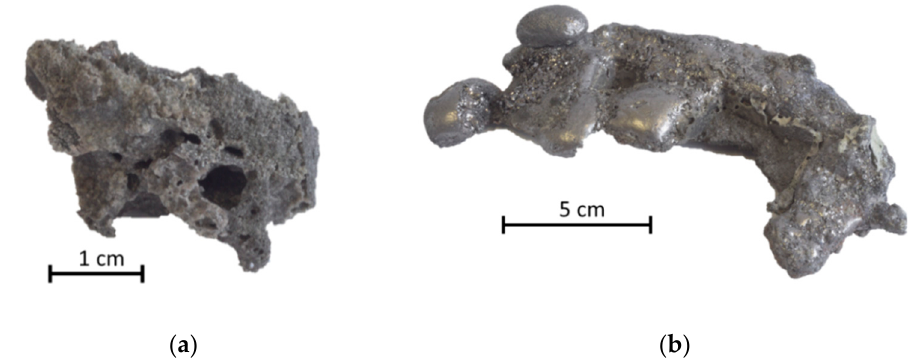
Figure 9. Obtained slag ( a ) and metal sample ( b ) from the experiment IM_NMC_C.